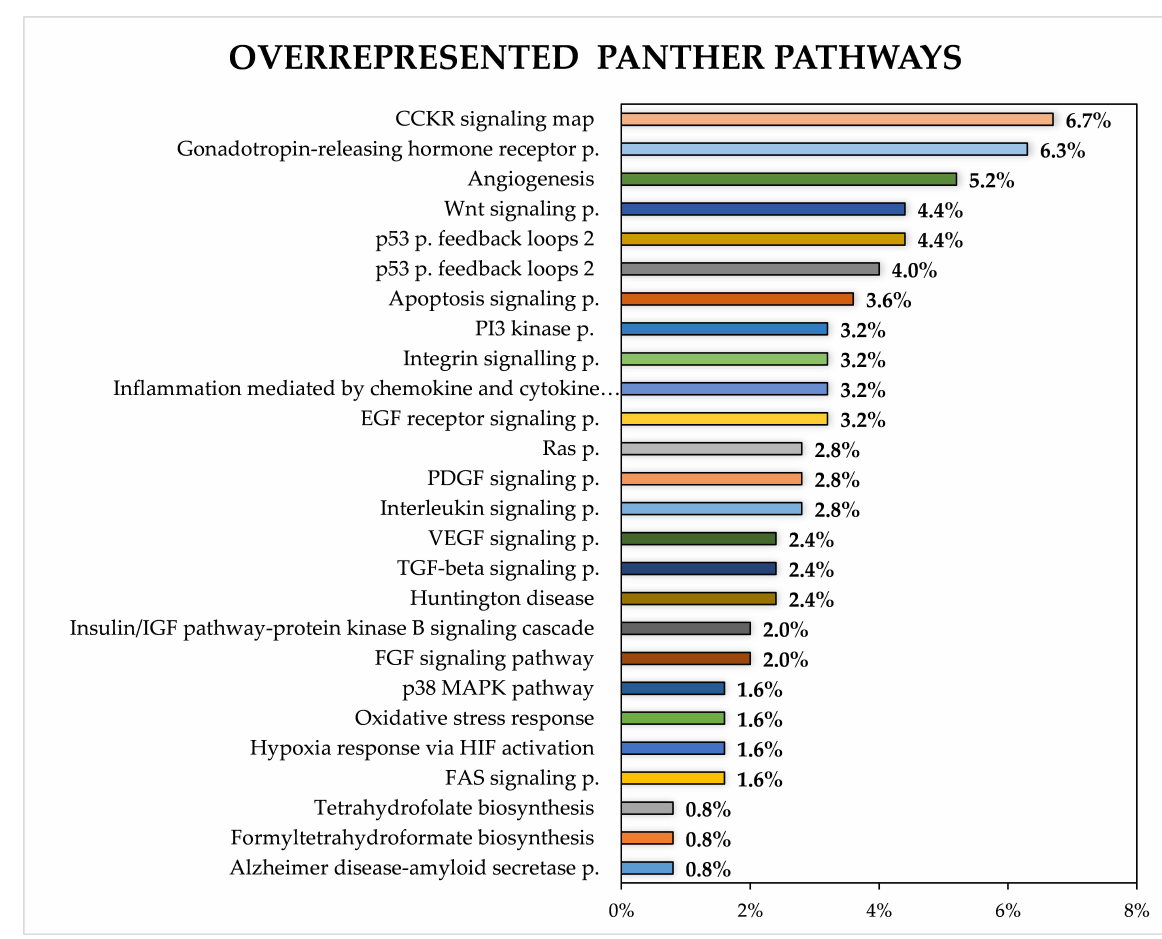
Figure 5. GO-slim analysis of target genes of up-regulated miRNAs in CRC. Classification is according to Panther pathways terms, and only significantly overrepresented terms are plotted ( p < 0.05; FDR < 0.05). FDR—false discovery